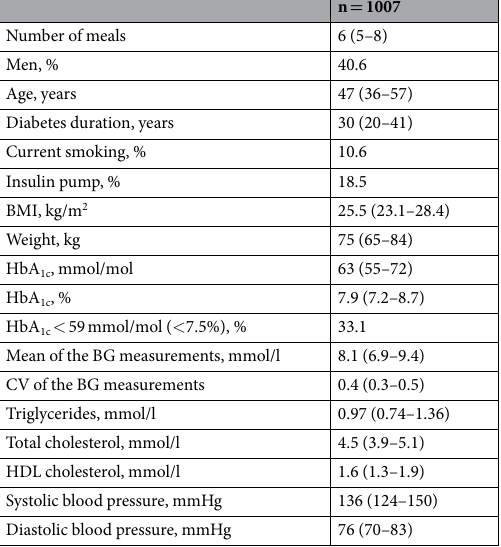
Table 1. Participant characteristics. Data are presented as frequency (%) or median (interquartile range). BMI, body mass index; BG, blood glucose; CV, coefficient of variation.